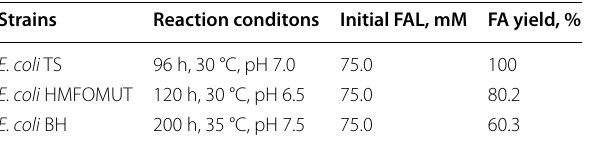
Table 3 Biological oxidation of FAL to FA with dehydrogenase‑ producing strains